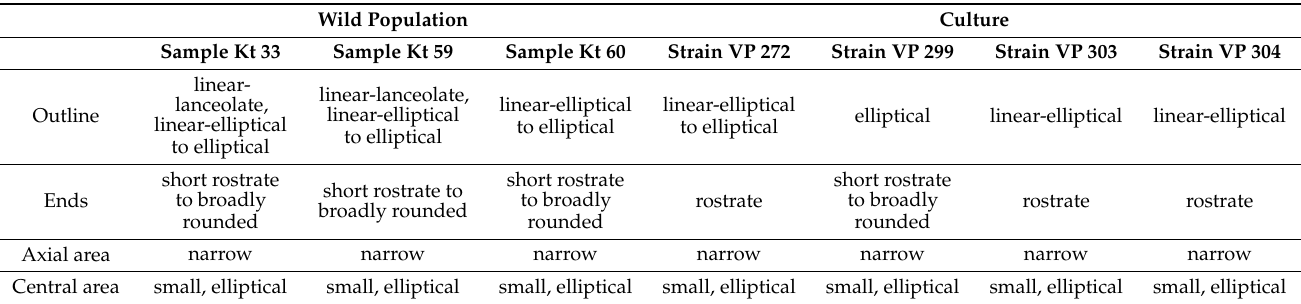
Figure 6. Phylogenetic position of Sellaphora terrestris sp. nov. (indicated in bold) within the Sellaphoraceae based on Bayesian inference for the 114 partial rb cL gene. The total length of the alignment is 957 characters. Values above the horizontal lines are bootstrap support the from ML analyses (<50 are not shown); values below the horizontal lines (or to the right of the slash) are Bayesian posterior probabilities (<0.9 are not shown). Strain numbers (if available) are indicated for all sequences. Clades indicated sensu Evans et al. [9], and Mann and Poulí č ková [12] are in bold. Table 1. Comparison of morphological characteristics of wild populations and cultures of S. terrestris sp.